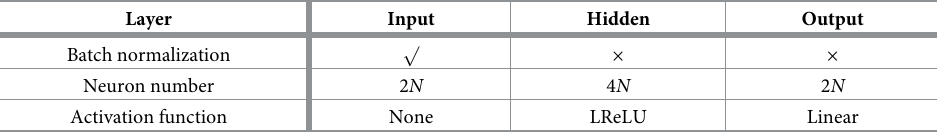
Table 5. Architecture of refinement